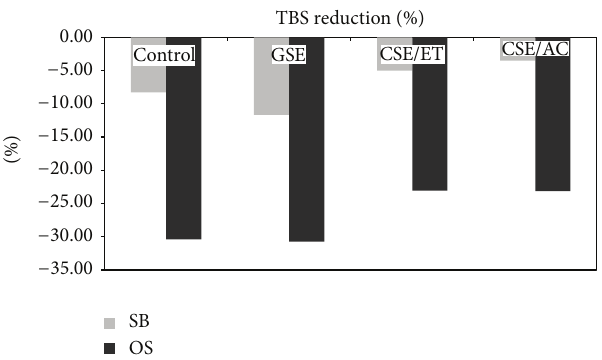
Figure 1: Graph illustration for the percentage of 𝜇 TBS reduction (%) for different dentin treatment after 12 months: GSE-grape seed, CSE/ET-cocoa seed in ethanol-water, CSE/AC- cocoa seed in acetone-water and control when used both adhesives: Single Bond Plus (SB) and One Step Plus